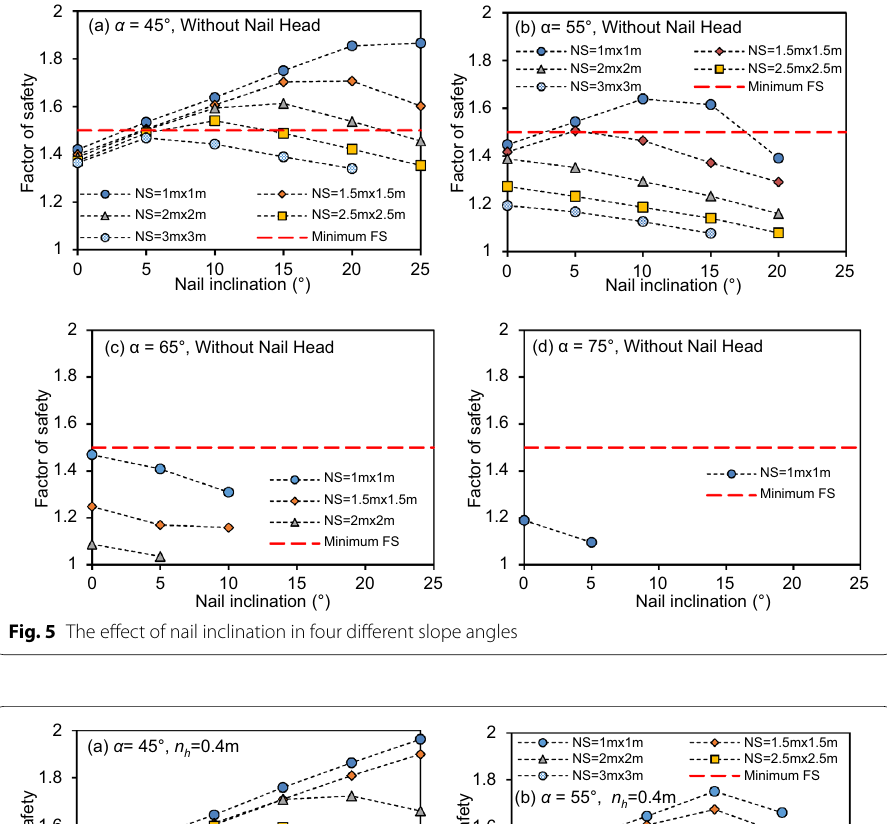
Fig. 5 The effect of nail inclination in four different slope angles